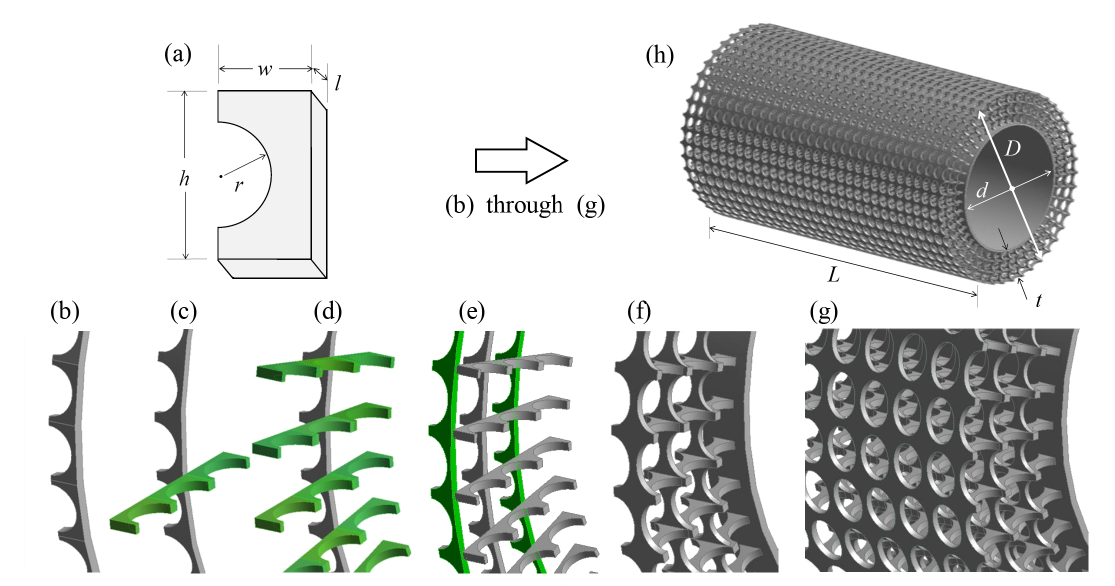
Figure 3. Stages of the creation of the SPCC using the ANSYS Workbench Geometry CAD package. Image ( a ) depicts the c-shaped chip piece that dictates the overall PPI and porosity of the SPCC. Stages ( b ) through ( e ) illustrate the components required to create the SPCC, where the addition from the previous step is illuminated in a green shading. Image ( f ) represents a mirrored-duplication of ( e ) about the vertical axis and ( g ) several duplications of ( f ) along the spanwise direction to produce image ( h ) the final SPCC design, labeled with key